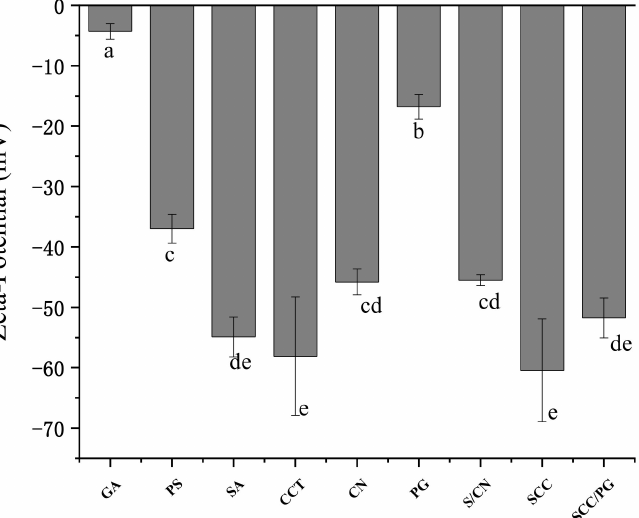
Figure 2. Zeta-potential of GA, PS, PG, pure hydrocolloid solutions, and PIPNs/GA solutions. Different lowercase letters indicate significant differences. GA: gallic acid, PS: porous starch, SA: sodium alginate, CCT: carboxymethyl chitosan, CN: cellulose nanofibers, PG: PS/GA, S/CN: SA/CN, PIPNs: polysaccharide interpenetrating network polymers, SCC: